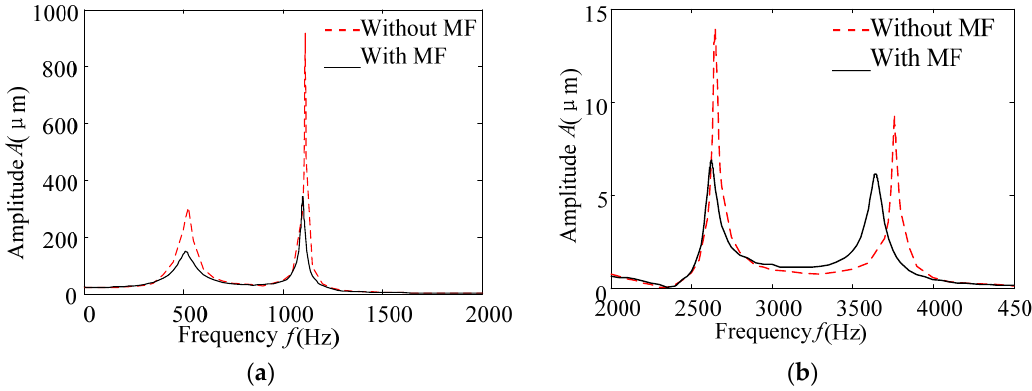
Figure 6. Tested harmonic responses in the x- direction (with and without magnetic fluids). ( a ) The tested harmonic responses (0–2000 Hz); ( b ) the tested harmonic responses (2000–4500 Hz).